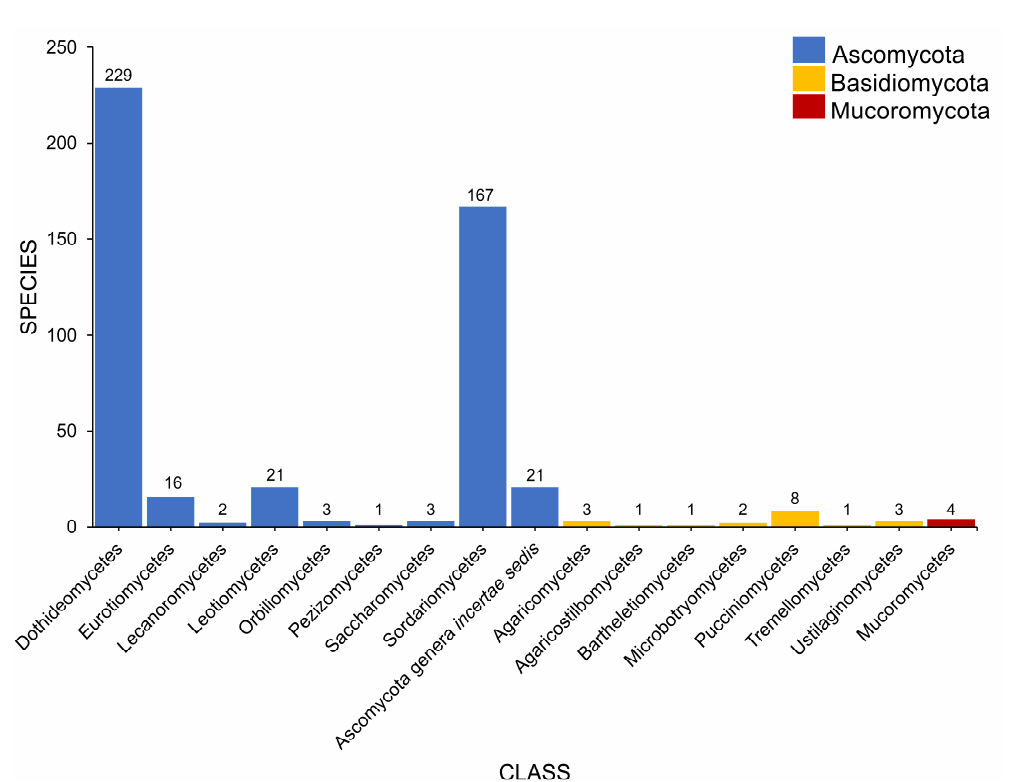
Figure 5. The distribution of salt marsh fungi in different fungal classes.